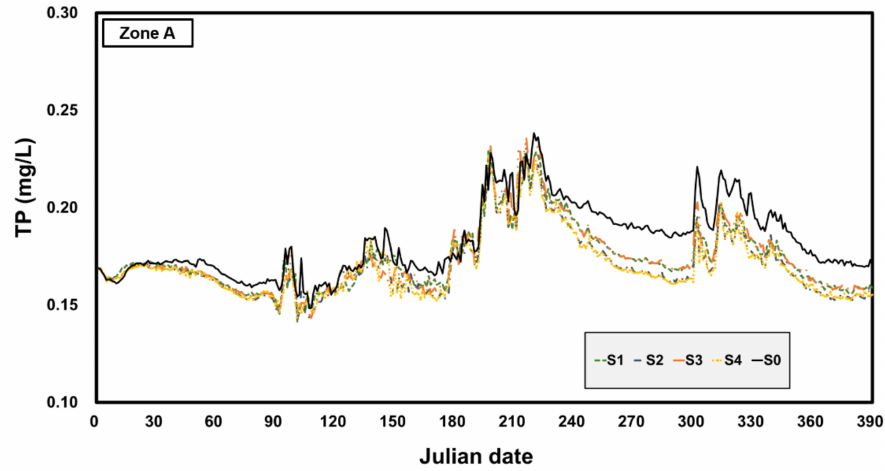
Figure 8. Simulated results of T-P concentration (Zone A, S0,